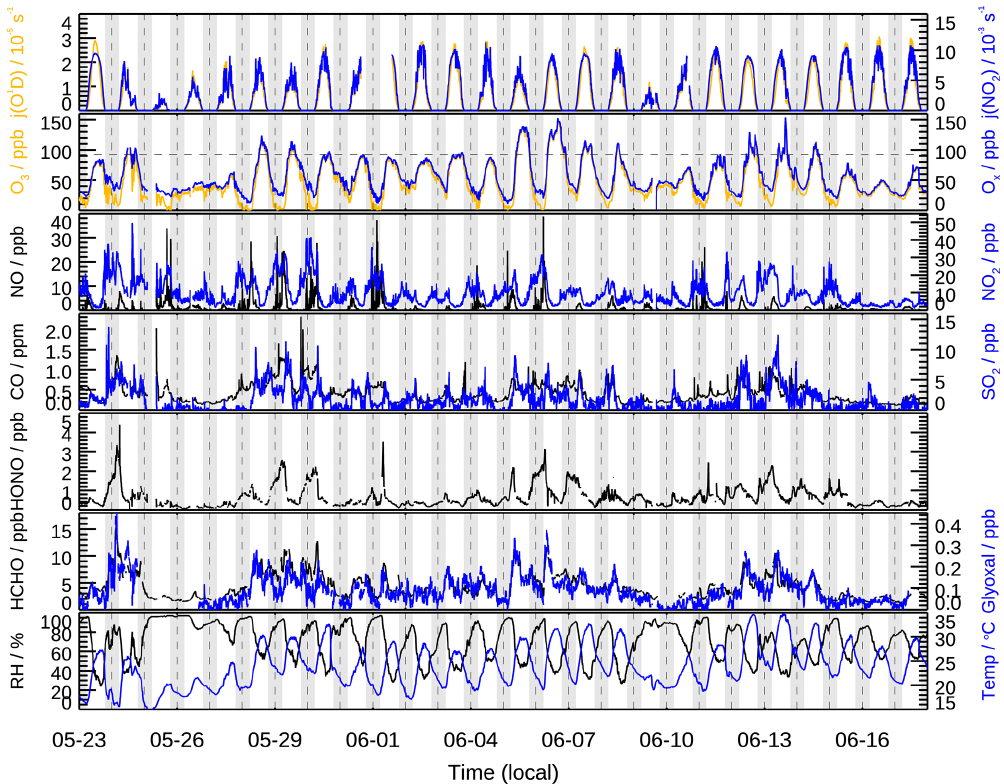
Figure 1. Time series of measured photolysis frequencies ( j (O 1 D), j (NO 2 )), relative humidity (RH), ambient temperature ( T ), and concen- trations of O 3 , O x ( = O 3 + NO 2 ), NO, NO 2 , CO, SO 2 , HONO, formaldehyde (HCHO), and glyoxal (CHOCHO). The dotted horizontal line represents the Chinese national air quality standard level II of O 3 (hourly averaged limit 93ppb). The grey areas denote